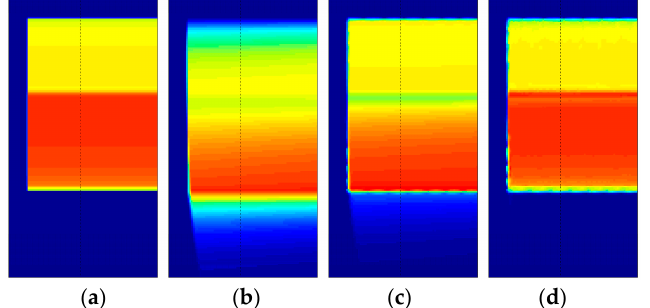
Figure 12. ( a ) Sharp intensity to be recovered, ( b ) blurred Gate 2 image obtained for blade rotation frequency of 269 Hz, ( c ) deblurred result as obtained from an invariant deblur with an assumed pressure of one atmosphere, and ( d ) recovered image after 13 iterations. Colors represent intensity. The dashed black line identifies the location ( r/R = 0.95) used to plot profiles in Figures 13 and 14. Axes are the same as in Figure 11. Rotation is counterclockwise; images are in Cartesian coordinates.